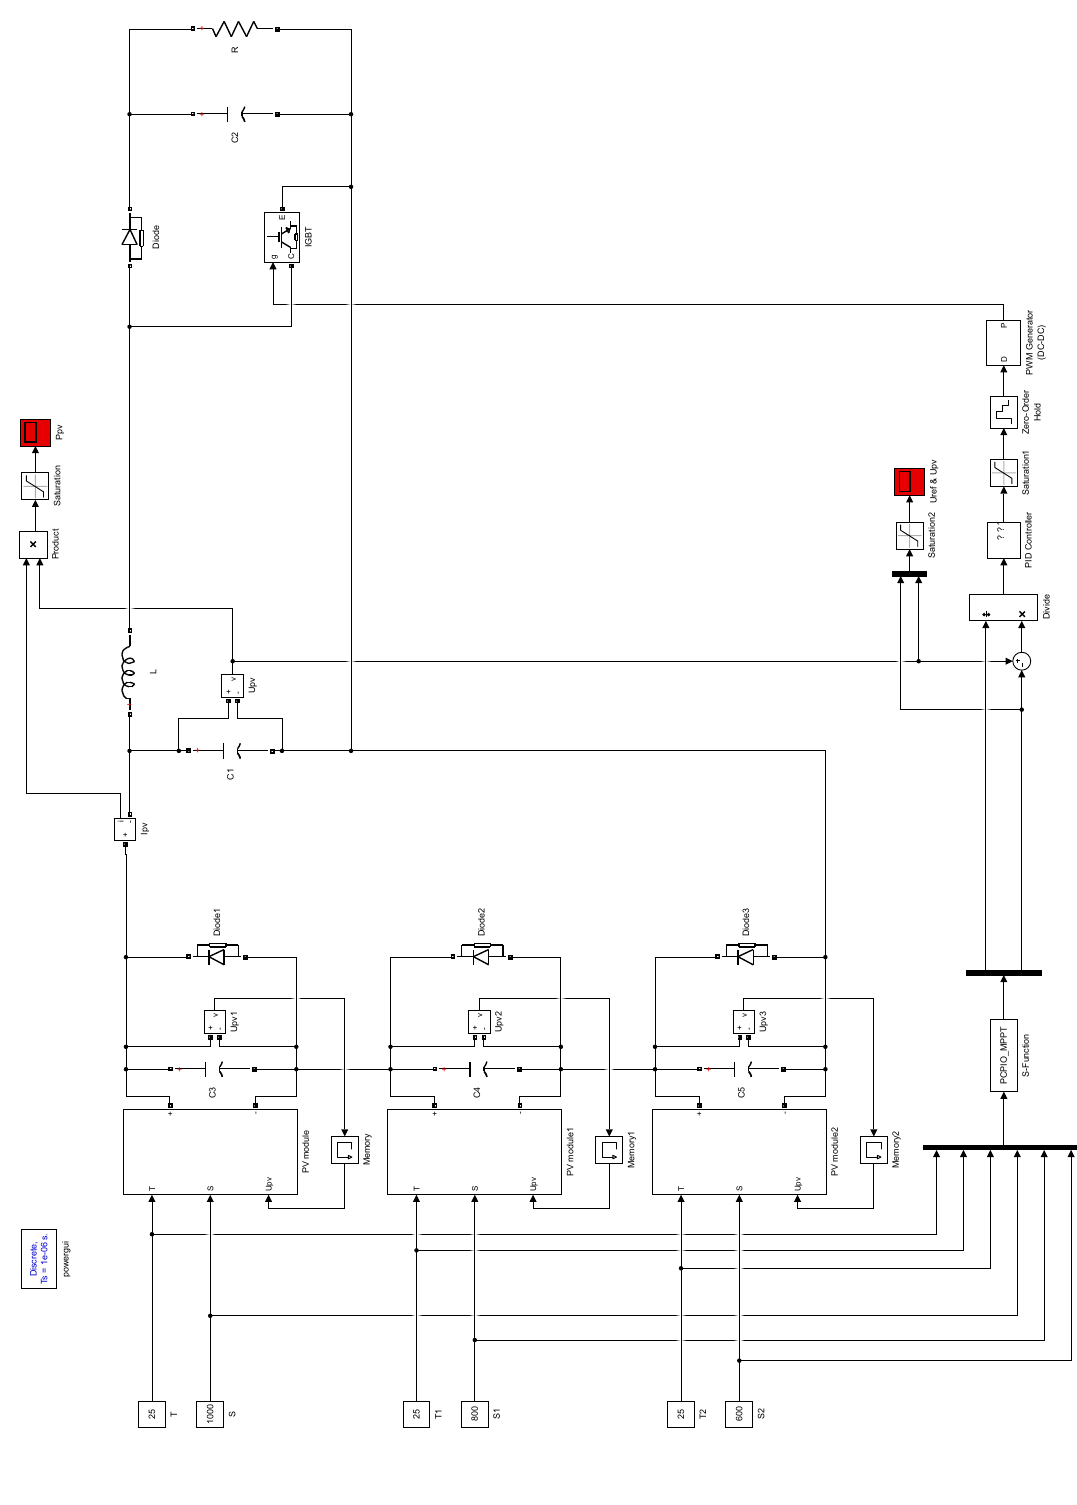
Figure 10. The part of the simulation model of PCPIO-based MPPT